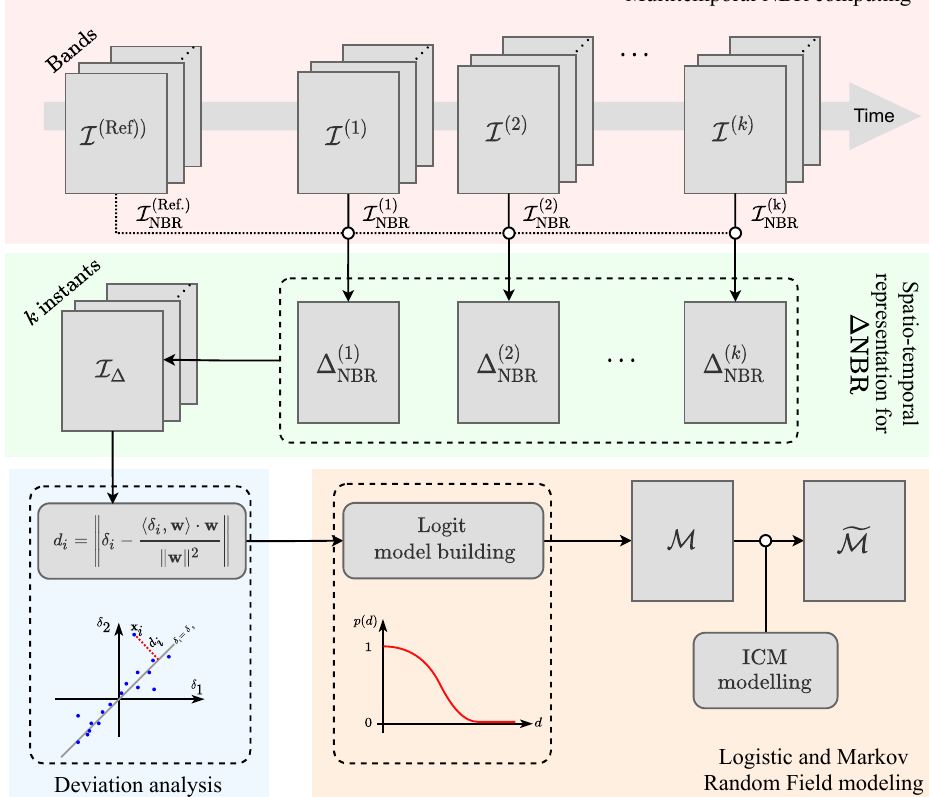
Figure 1. Proposed method